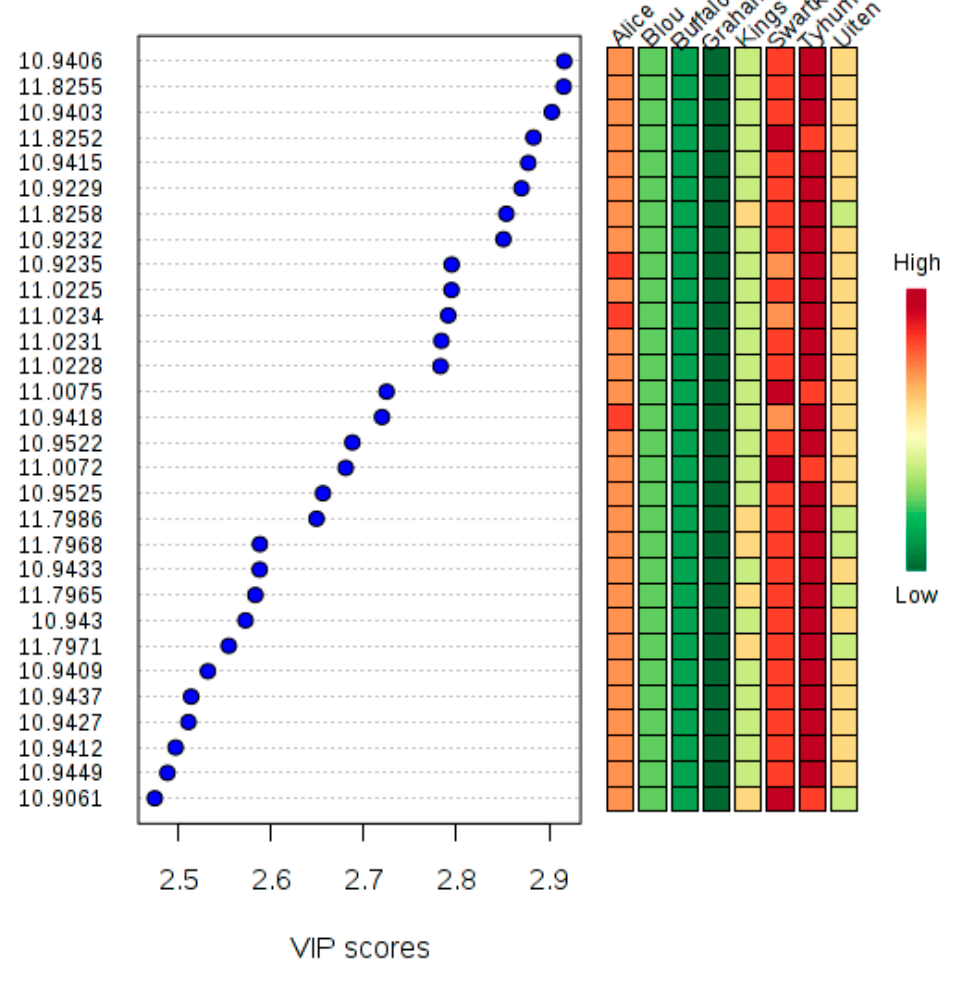
Figure 3. Important features as identified by PLS-DA. The colored box on the right indicates the relative concentrations of the components in the groups listed.